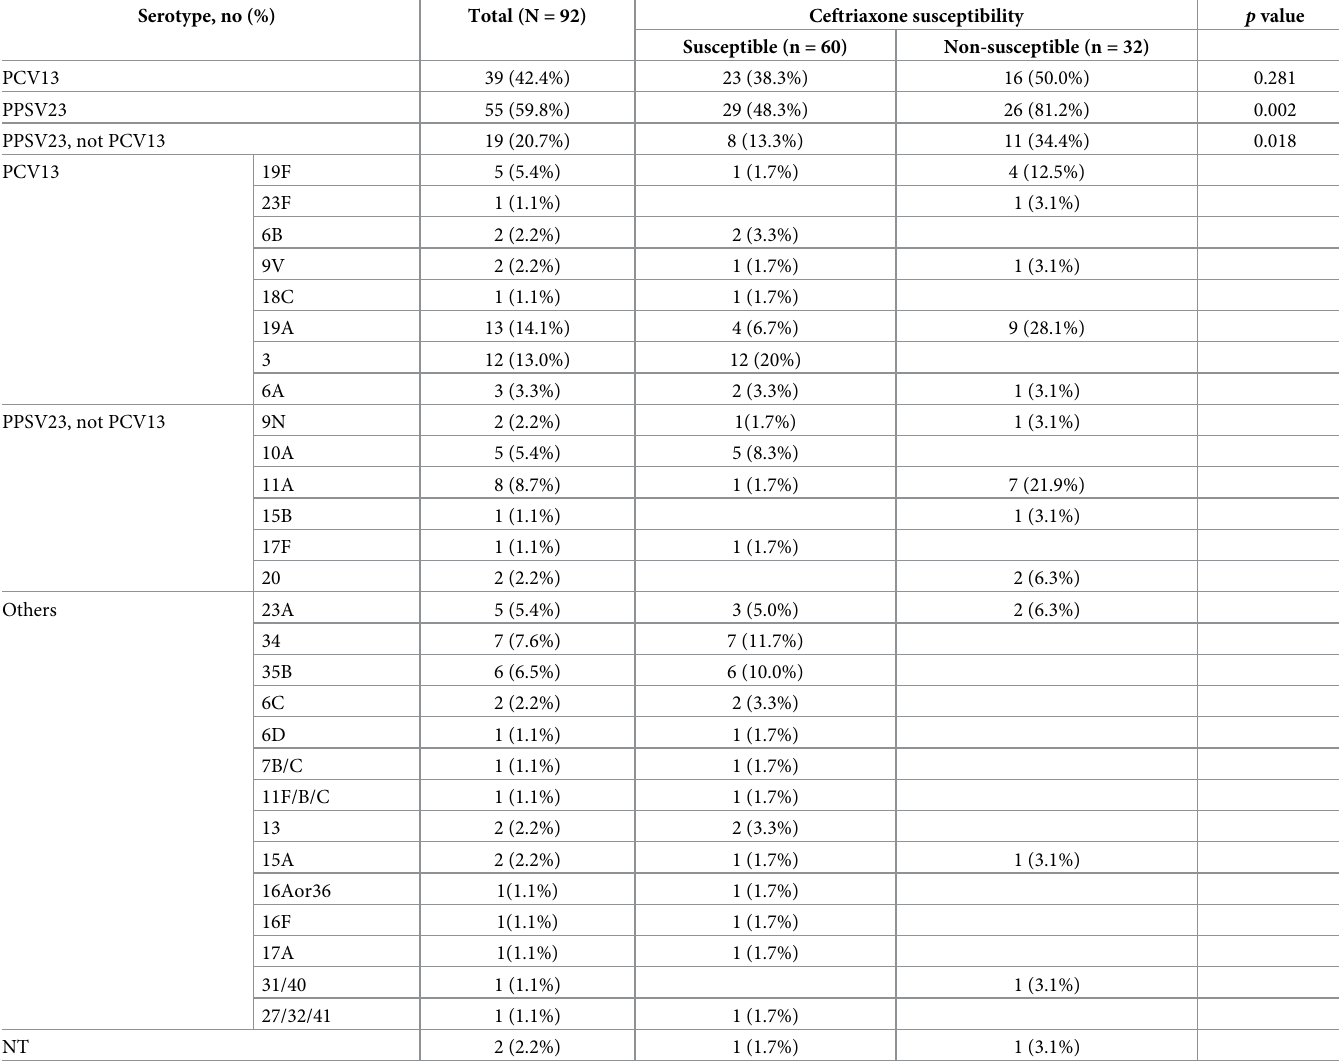
Table 4. Serotype distribution of Streptococcus pneumoniae isolates. Serotype, no